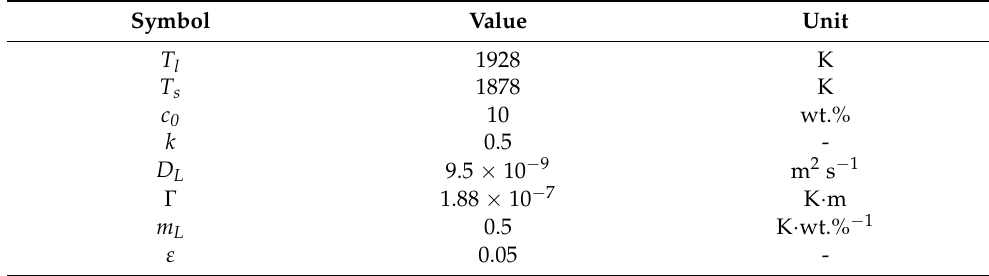
Table 3. Physical parameters of the main TC4 alloys used in the simulation [52]. Symbol Value Unit T l 1928 K